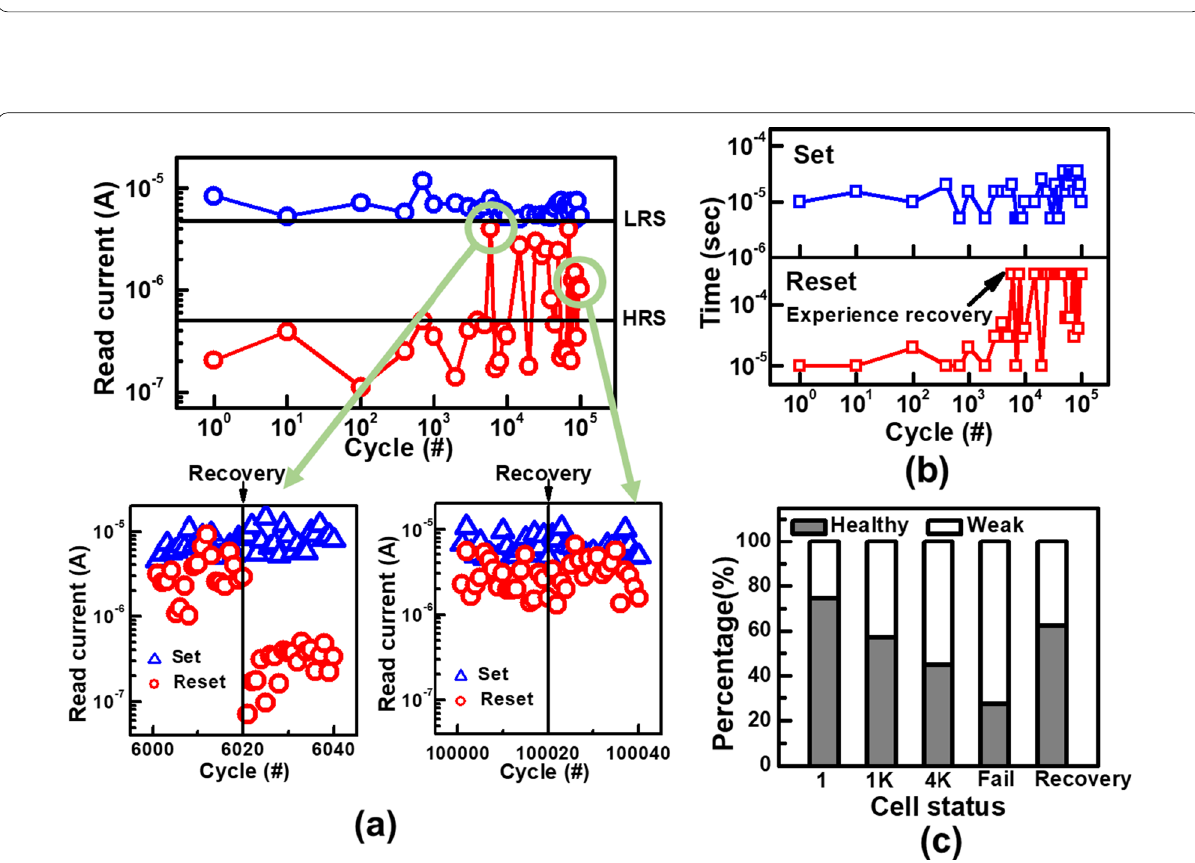
Fig. 6 a 100 k ISPP set/reset cycles. Cells lost read widows after 6 k cycles can be recovered by 5 strong reset pulse with conditions V WL V SL 2 V and pulse width of 50 μs. The reset recovery treatment is invalid after 10 k cycles. b Set/reset time required to complete state switch during = 100 k cycles. c Shift in cell type, defined by their noise features, are found during ISPP cycling